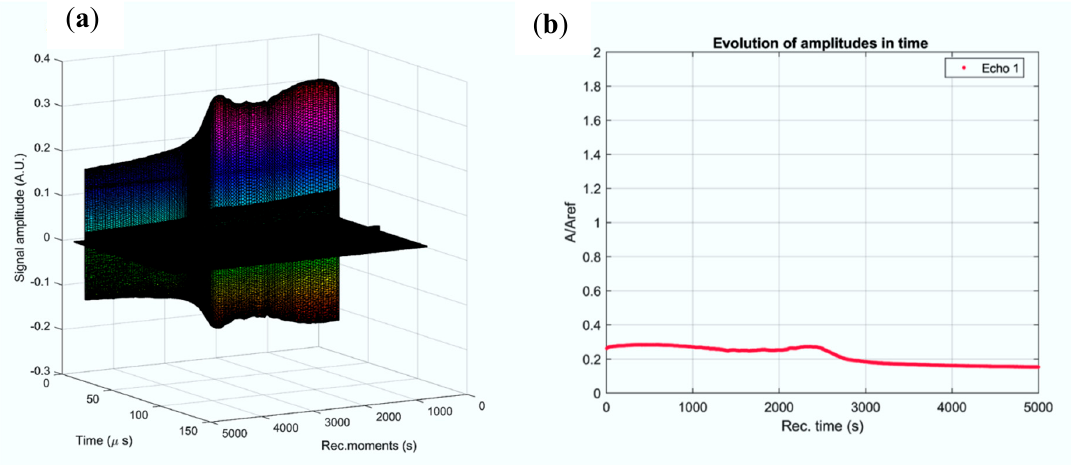
Figure 1. ( a ) Recorded signals at 5 s recording interval. A decreasing amplitude of the first echo is visible in colors, whereas the second is significantly weaker (in black); ( b ) Relative amplitudes evolution vs. the recording moments ( a ).